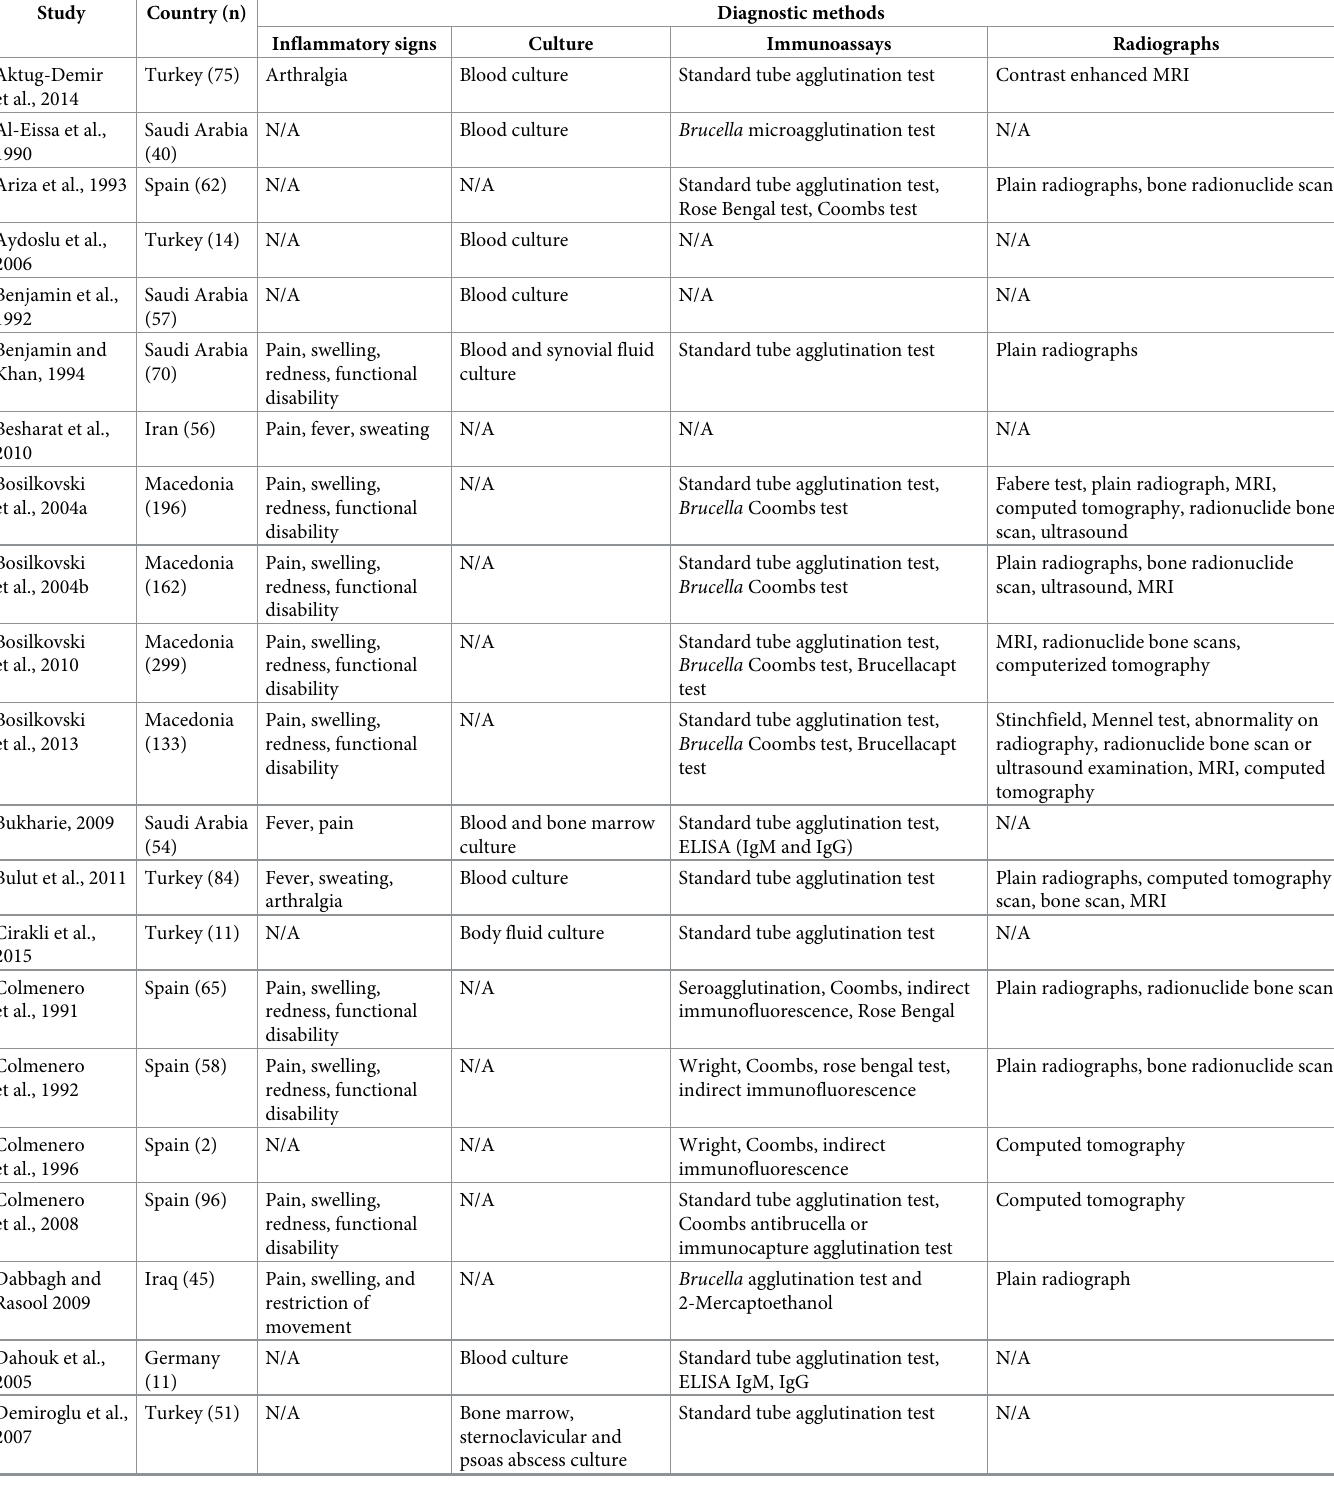
Table 2. Diagnostic methods of osteoarticular brucellosis used in included